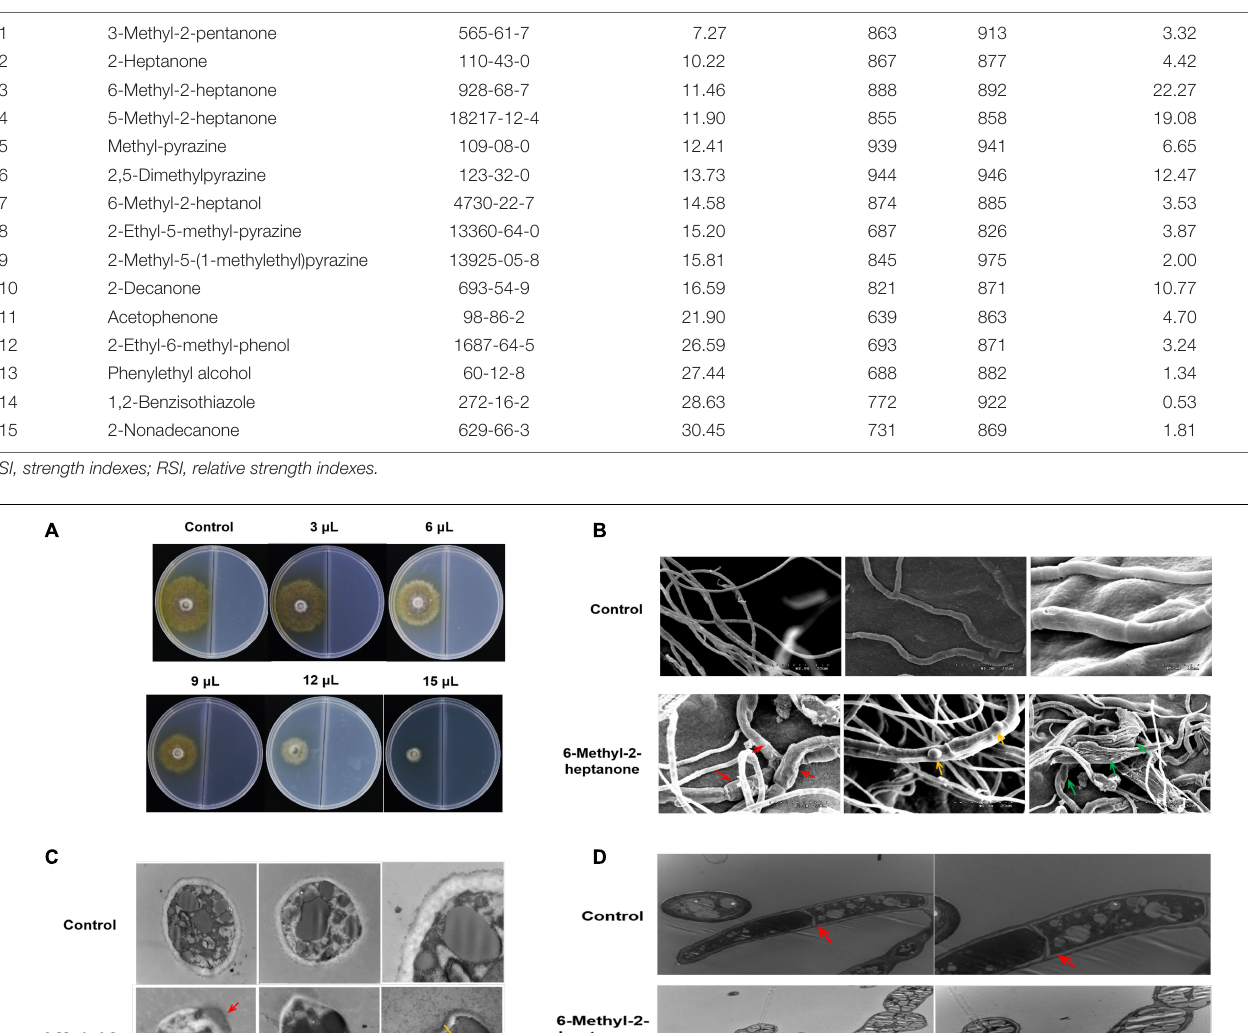
were thinner (green arrows, Figure 2C ) and even damaged (red arrows, Figure 2C ), which resulted in the movement of the cytoplasmic content toward the ruptured cell walls or cytoplasmic membranes (red arrow, Figure 2C ). The